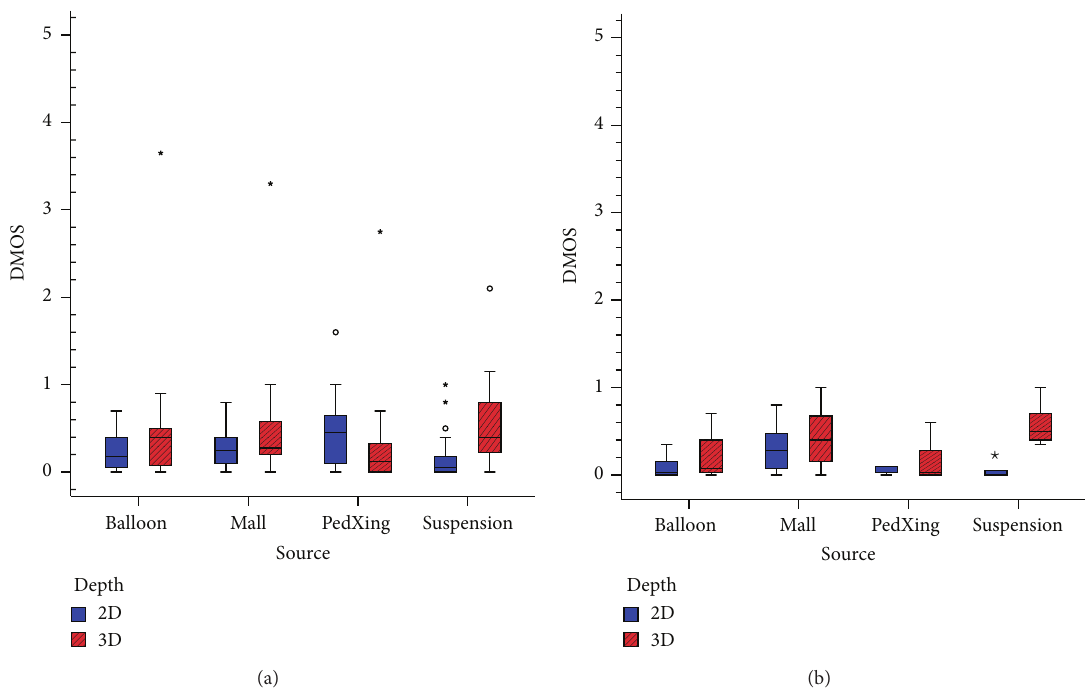
Figure 3: Boxplots of the absolute difference in scores for the eight pairs in experiment 2 comparing original versus original (either for 2D content or for 3D content): (a) the boxplot showing the results of all subjects of experiment 2 and (b) the boxplot showing the results after selecting a subset of the